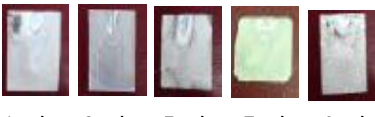
Figure 1:Ti plate after coating Examination of surfaces: